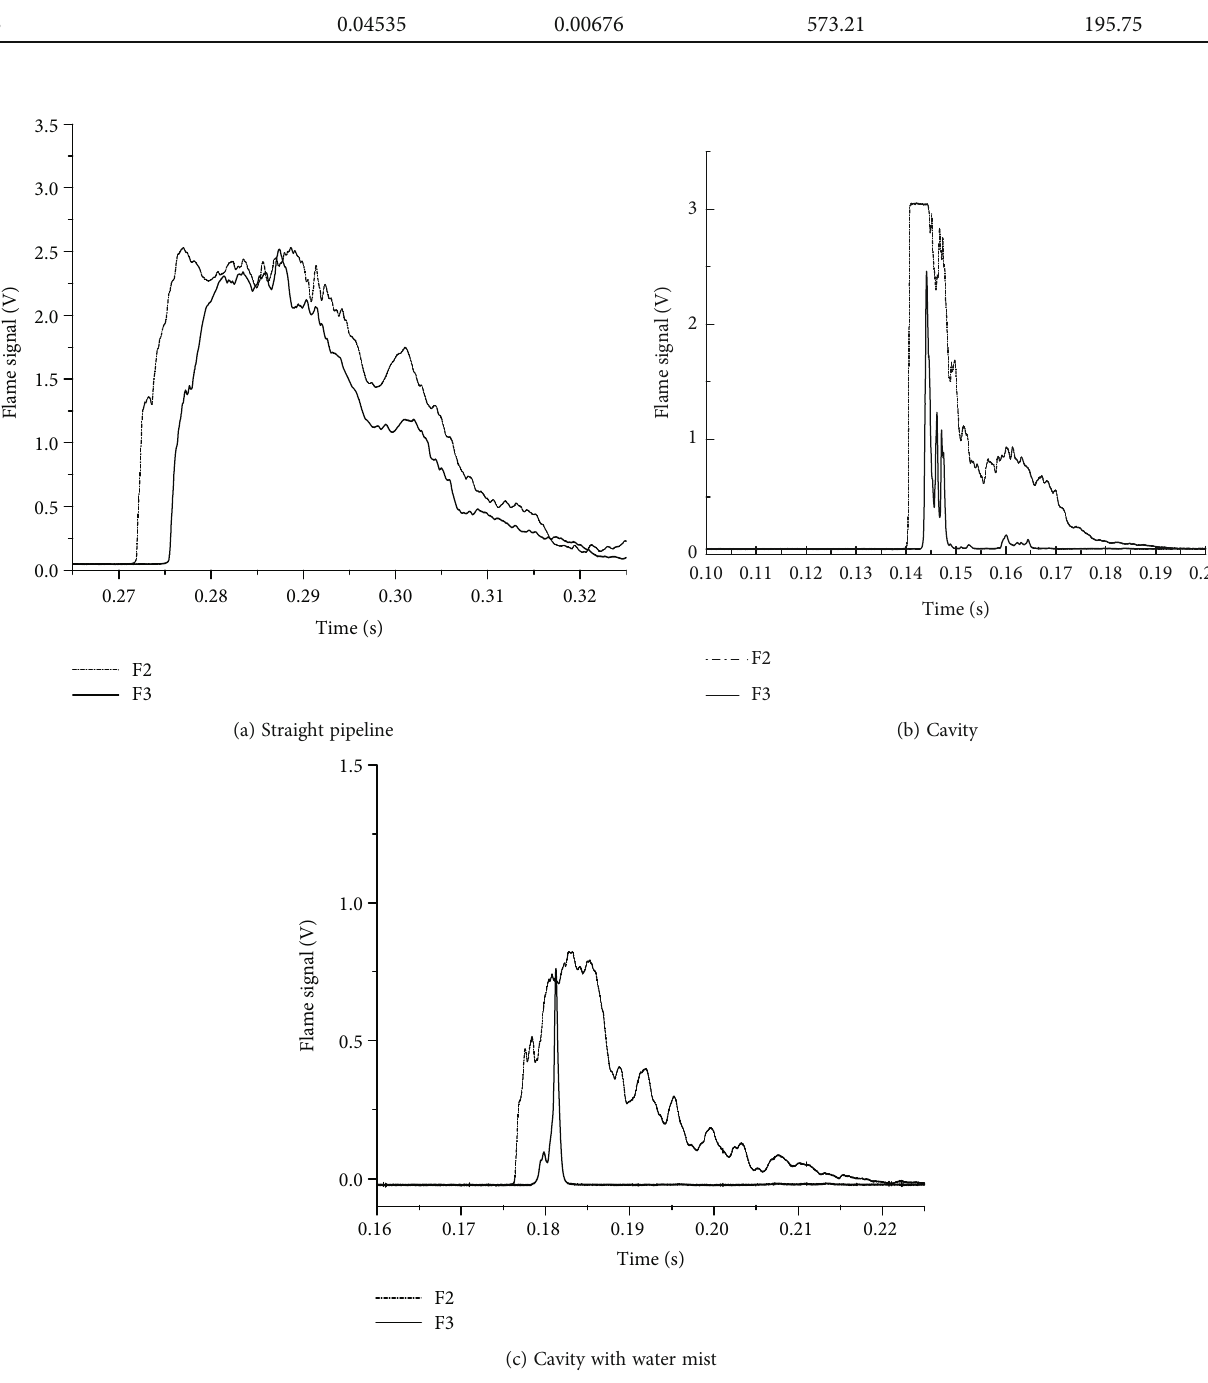
Figure 5: Explosion fl ame intensity signal at measuring points F 1 and F 3 under di ff erent working